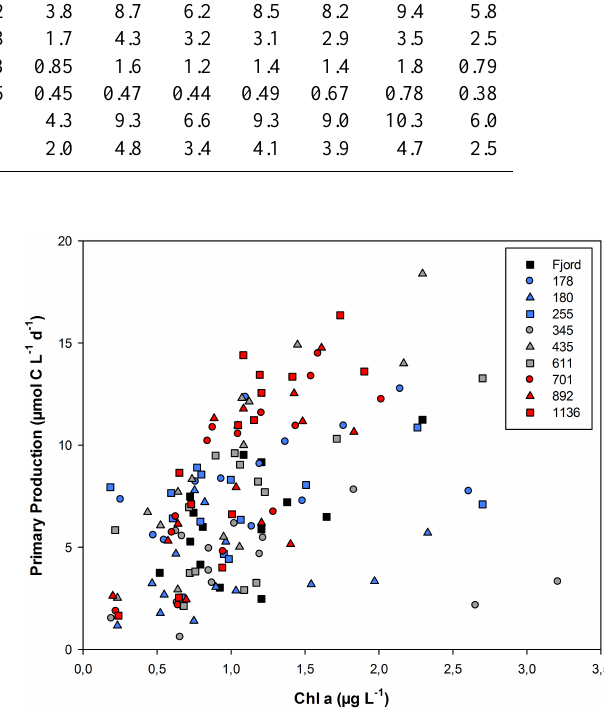
Fig. 3. Biomass changes of the phytoplankton community in the nine mesocosms as indicated by chlorophyll a (chl a ) concentration. Fig. 4. Total primary production (PP POC + PP DOC ), as determined for each of the nine mesocosms and for the fjord during the meso- cosm study, was not related to chl a concentration. Red symbols: high p CO 2 mesocosms (M5, M6, M9), grey symbols: medium p CO 2 mesocosms (M1, M4, M8), blue symbols: low p CO 2 meso- cosms (M2, M3, M7), black symbols: